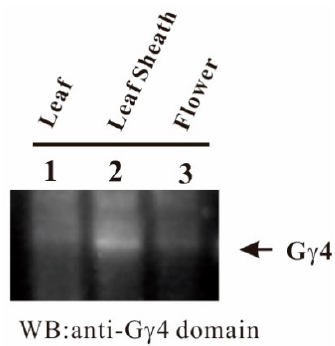
Figure 6. Tissue-specific accumulation of G γ 4 in wild type (WT). Ten micrograms of each plasma membrane protein fraction of leaf, leaf sheath, and flower of WT was analyzed by sodium dodecyl sulfate-polyacrylamide gel electrophoresis and western blotting using anti-G γ 4 domain antibody. Lane 1, leaf from etiolated seedling; lane 2, developing leaf sheath at 8th leaf stage; lane 3, 1–5 cm flower. WB: western blot.